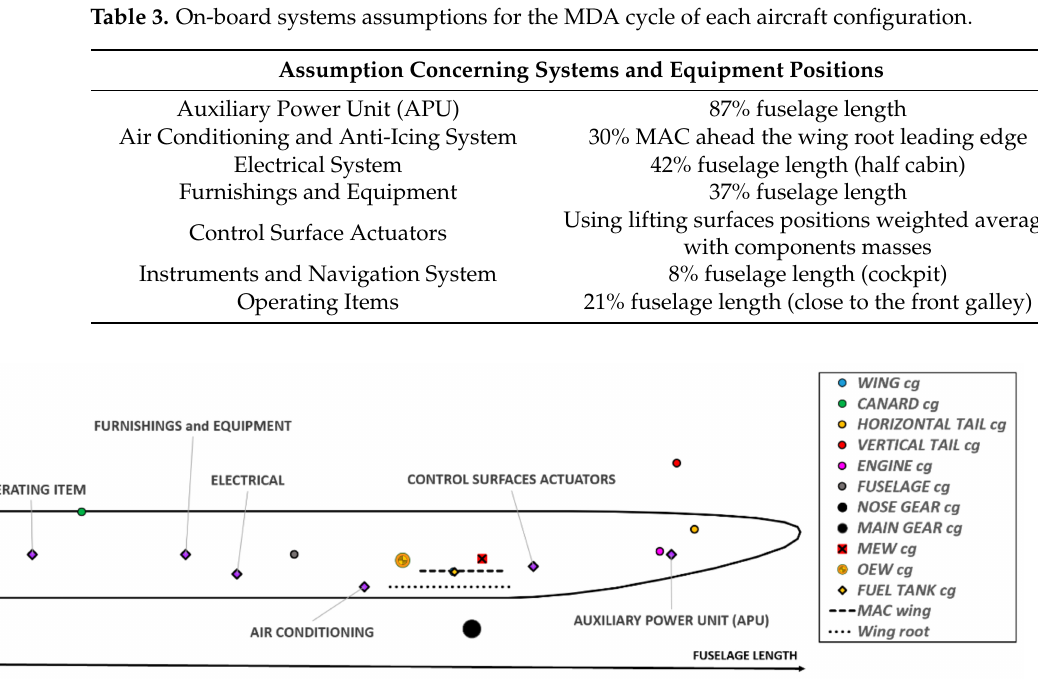
Figure 7. Example of aircraft main components and systems center of gravity positions for a three-lifting-surface